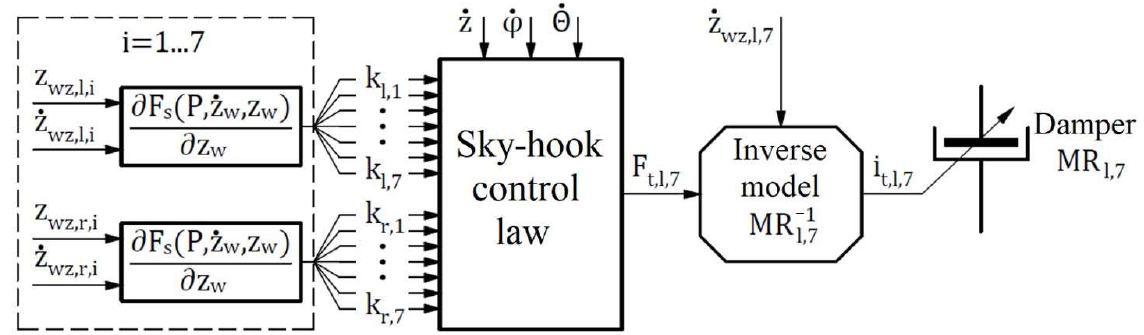
Figure A3. The control law for the magnetorheological damper on the left side and the seventh axis (MR l,7 ).